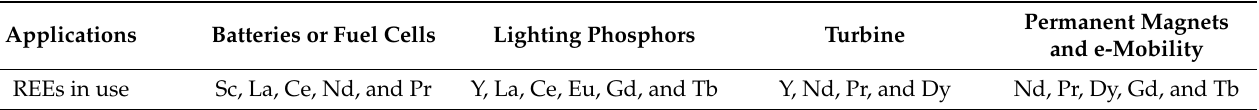
Table 1. Uses of different REEs in specific energy technologies [1,3,8,13].